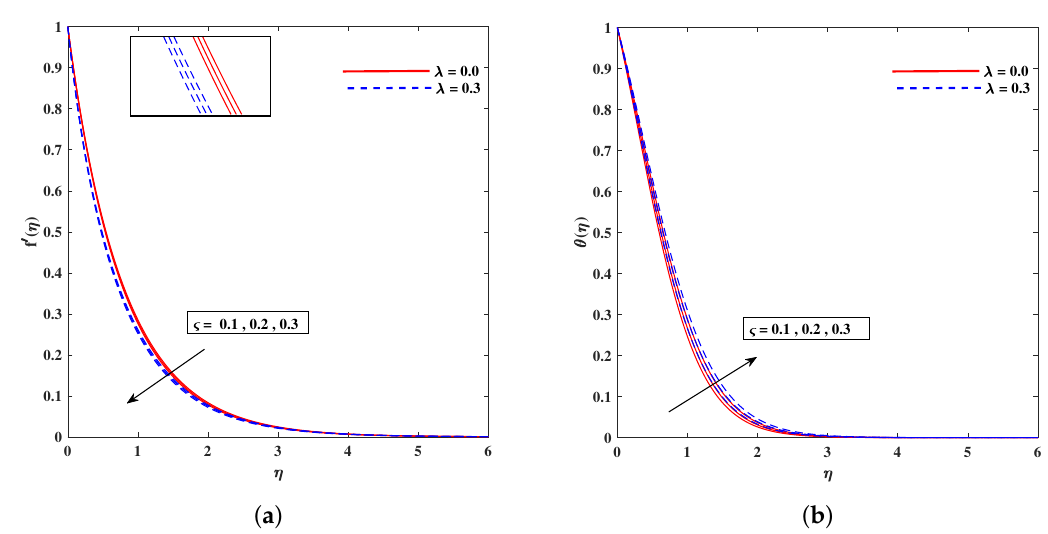
Figure 14. Fluctuation of ς on velocity ( a ) and temperature profile θ ( η ) ( b